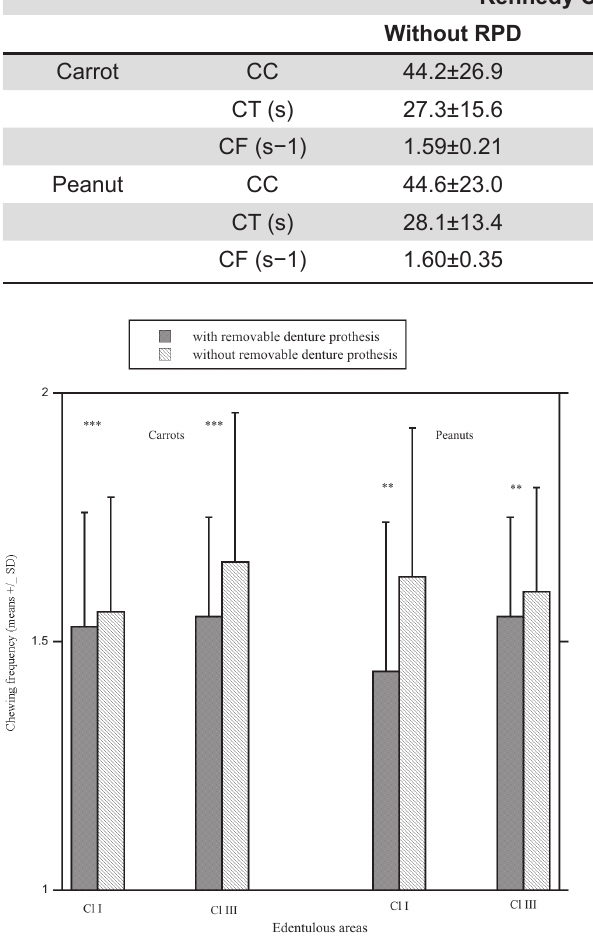
Figure 2- Mean chewing frequency ± standard deviation of the carrot and peanut with and without removable partial denture prostheses according to the edentulous areas (Kennedy Class). Repeated measure procedure was used for intergroup comparisons (***p<0.001, **p<0.01)